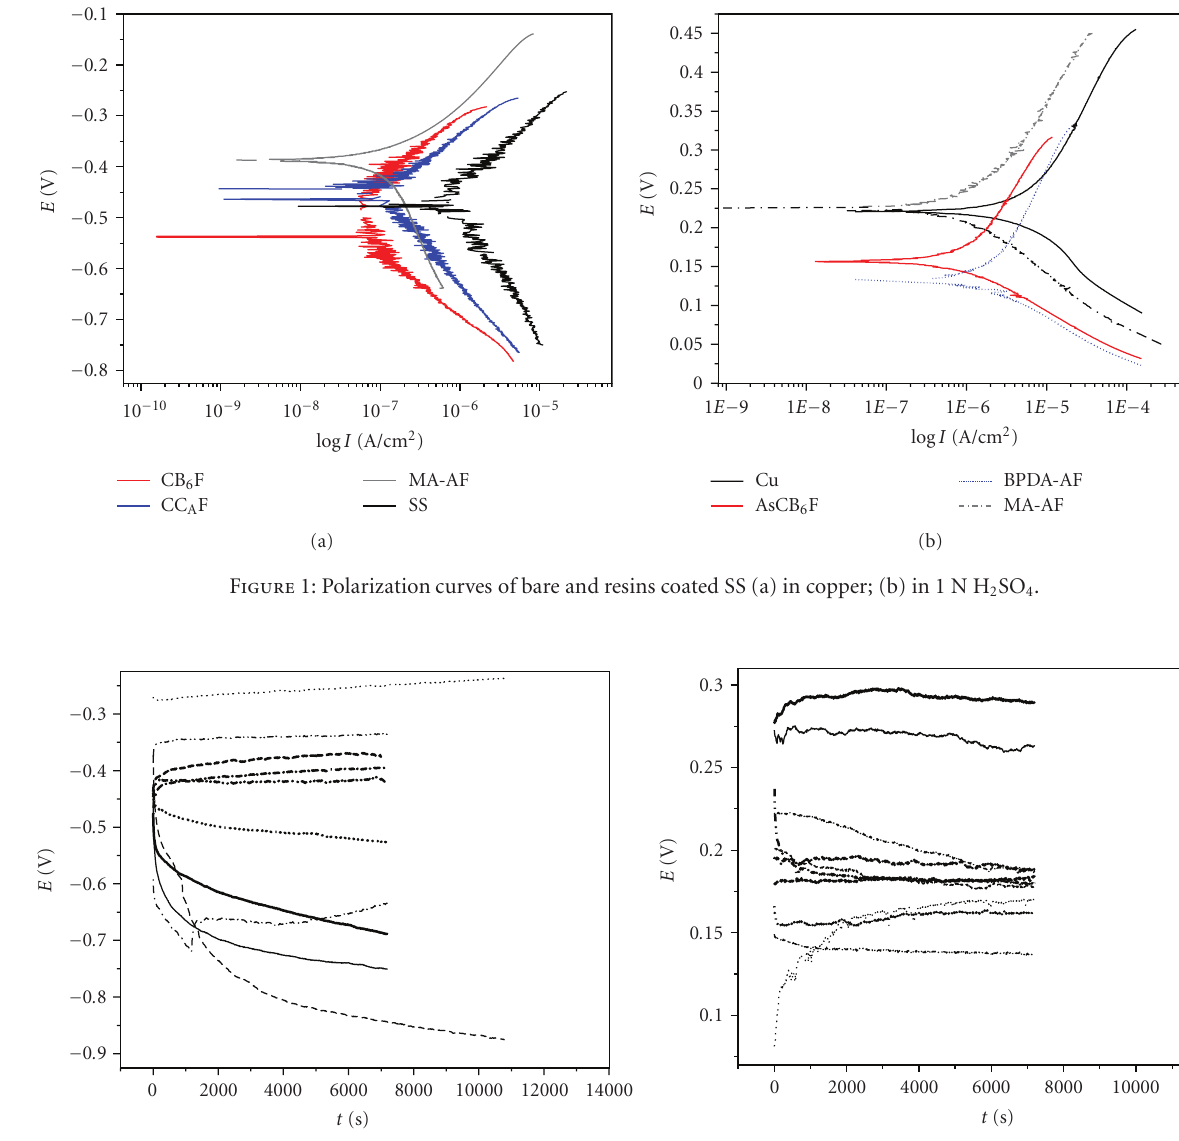
The OCP values of coated steel are decreased